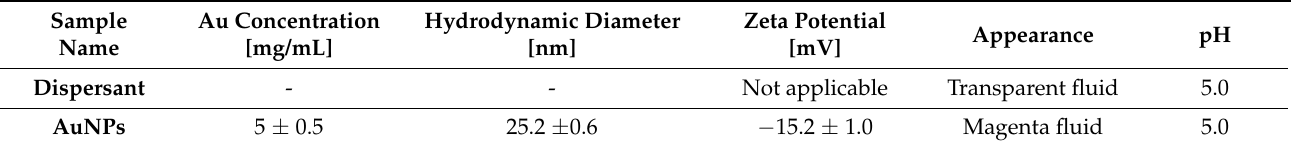
Table 1. Dispersant and AuNP characterization (Colorobbia Consulting srl). Abbreviations: nm = nanometer; mV = millivolt; %wt = weight